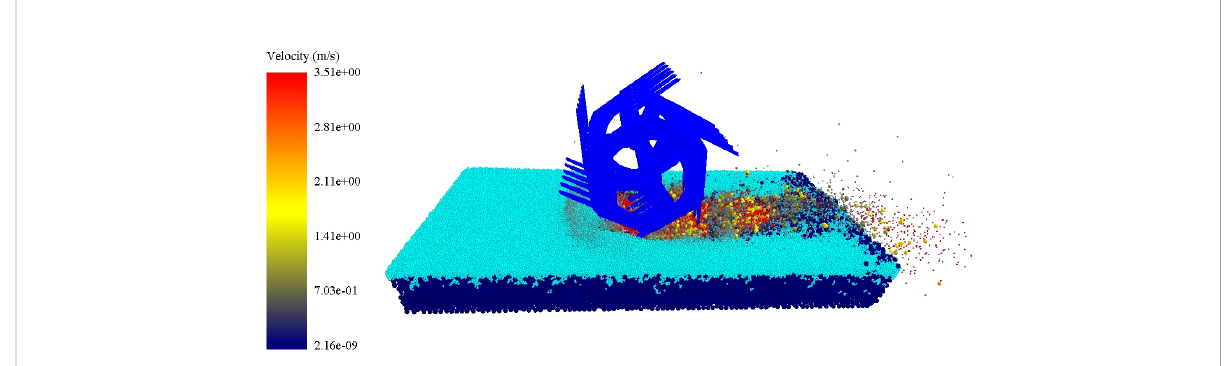
FIGURE 6 Simulation diagram of soil particle velocity at installation angle a =